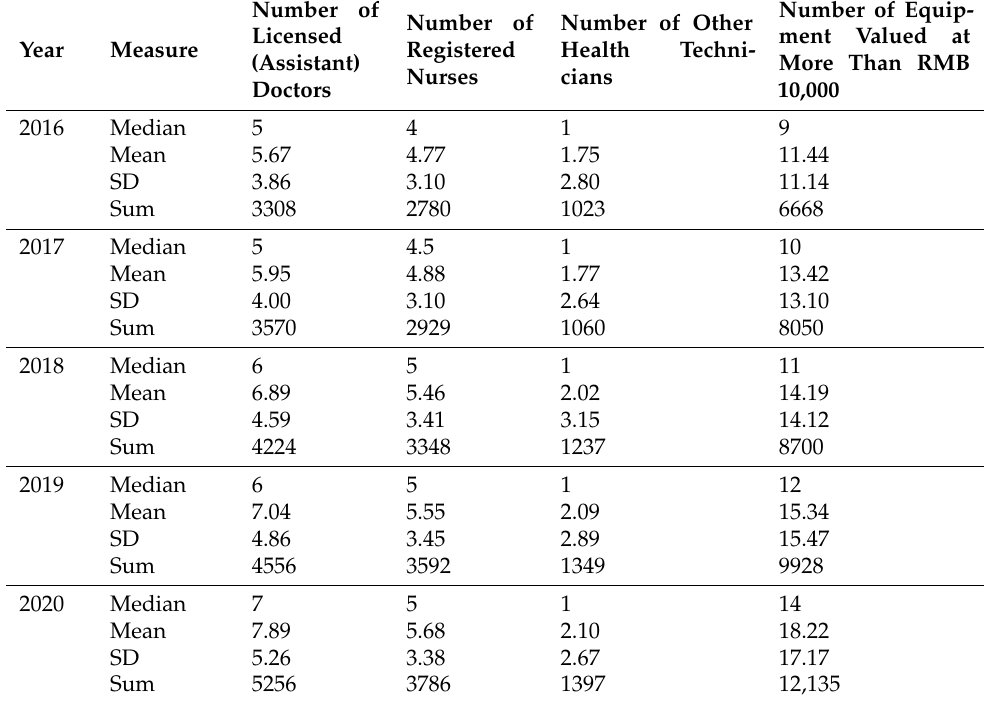
Table 2. Descriptive statistics of inputs of the DEA model.